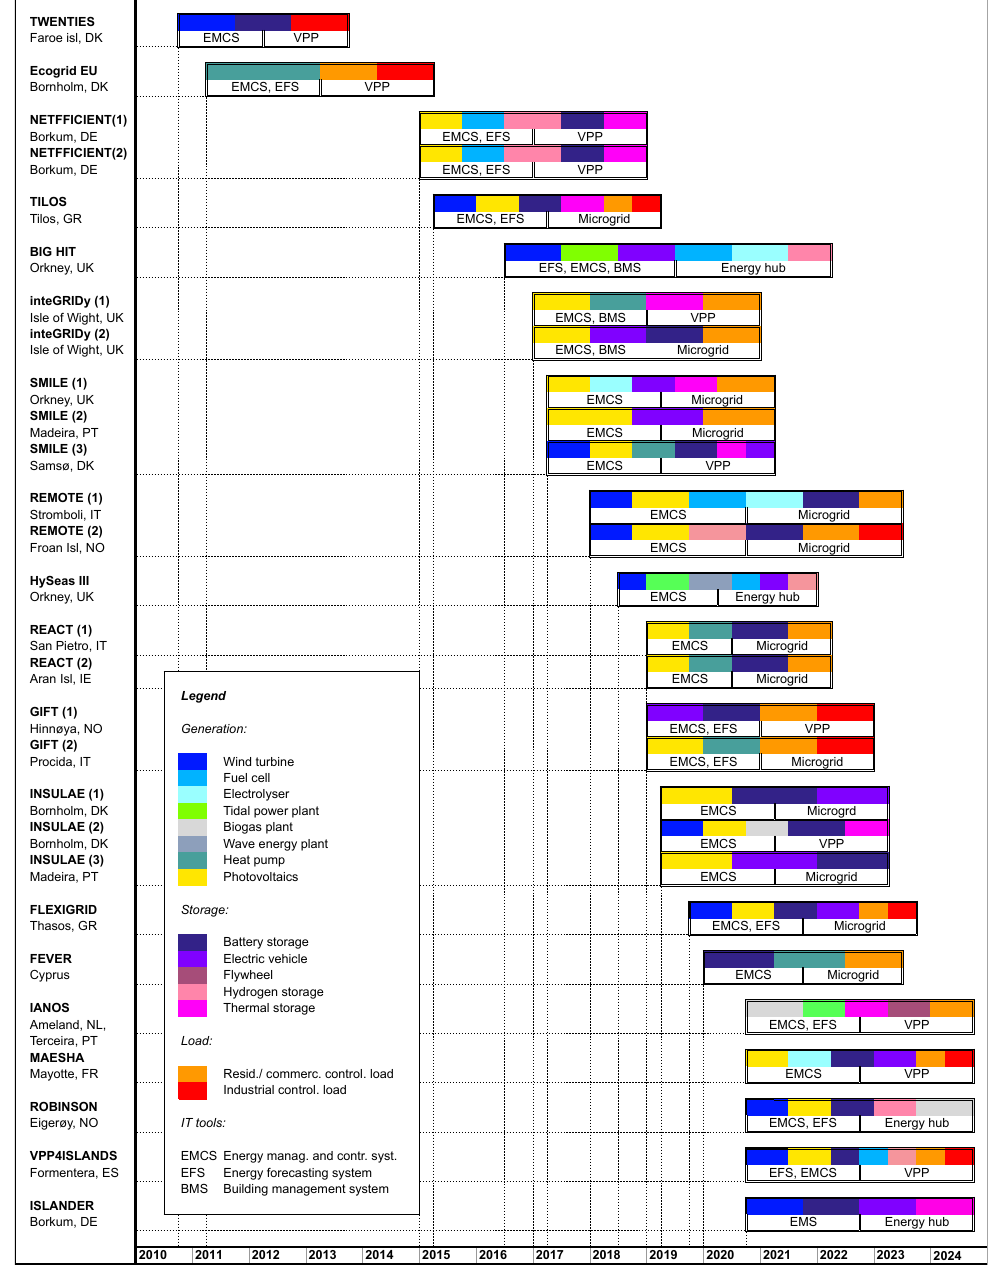
Figure 3. Technologies and aggregation approaches, demonstrated in the studied pilots, and temporal distribution of the